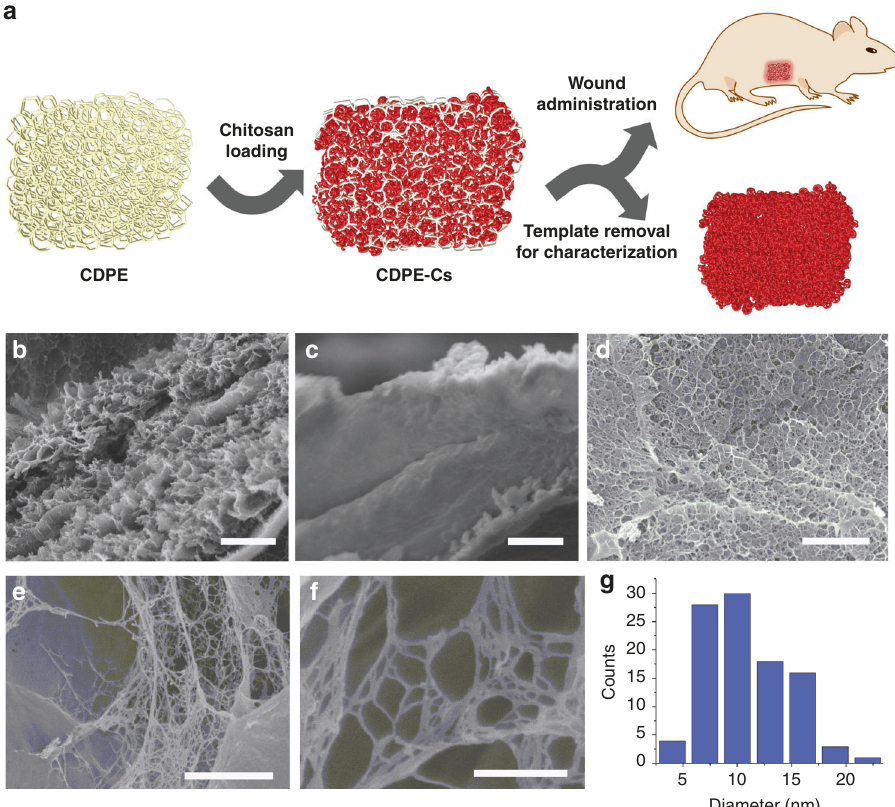
Fig. 2 Prepared materials exhibit amorphous, macroporous morphology. a Simpli fi ed illustration of the chitosan templating process, administration of CDPE-Cs to wound site, and template removal for imaging. b SEM image of CDPE after drying by lyophilization, showing complex, porous morphology (scale bar is 2 µ m). c SEM image of chitosan-loaded composite CDPE-Cs gel after lyophilization (scale bar is 2 µ m). d SEM image of templated chitosan material, displaying a honeycomb-like structure (scale bar is 2 µ m). e – f Magni fi ed SEM images of nano fi brillar domains in the templated chitosan, with a web-like morphology within the network cavities (scale bars are 500 nm and 300 nm, respectively). g Histogram plot showing the distribution of fi ber diameters measured by